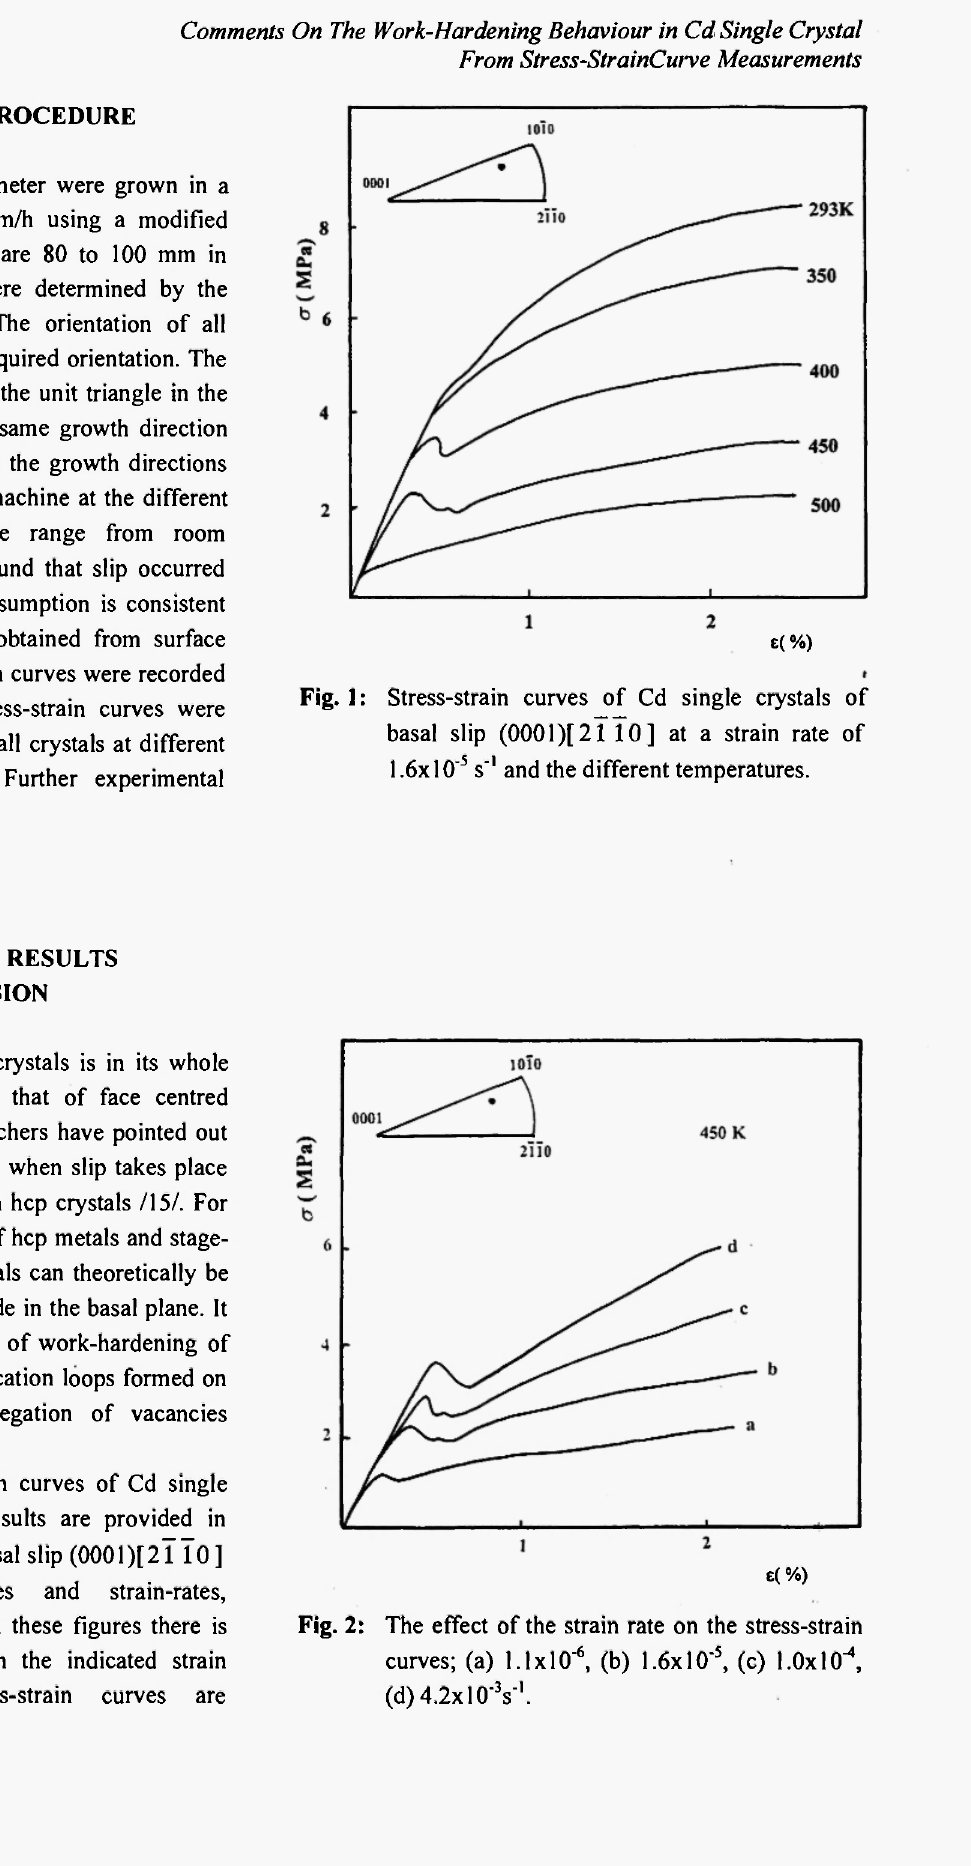
Fig. 1: Stress-strain curves of Cd single crystals of basal slip ( 0 0 0 1 ) [ 2 l l 0] at a strain rate of 1.6xl0" 5 s' 1 and the different temperatures.